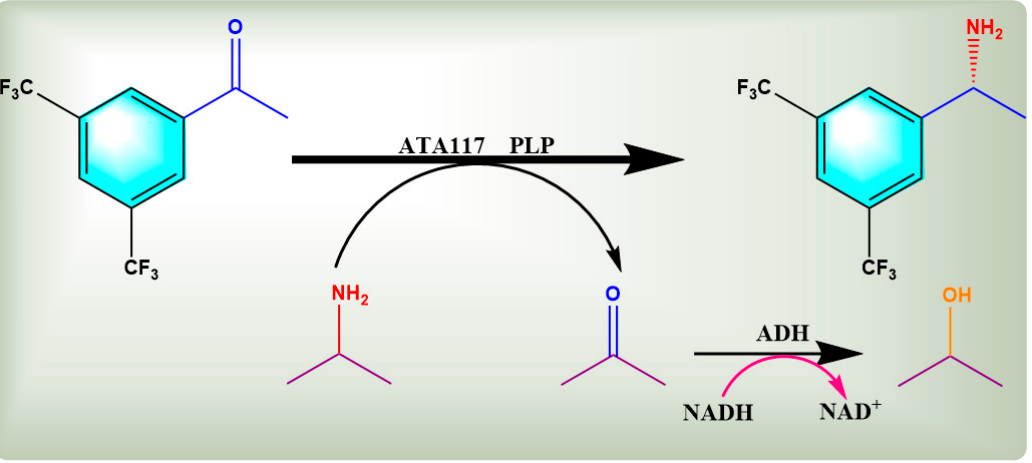
Figure 1. Schematic diagram of the reaction mechanism of ATA117 and ADH double enzymatic cascade reaction for amination of BPO to R-BPA. Table 1. PCR process for the construction of recombinant